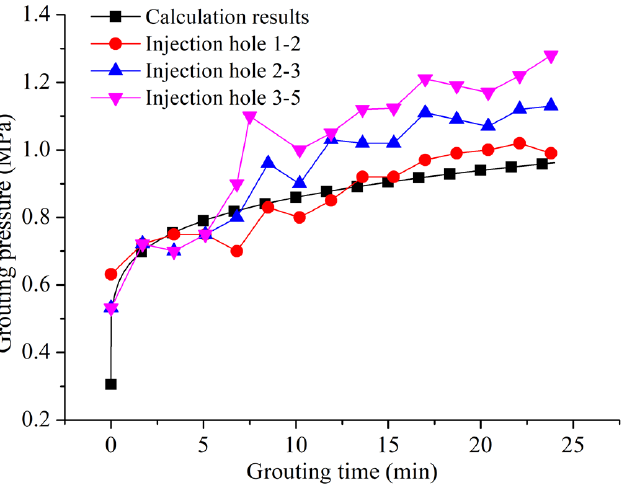
Figure 19. Comparison on grouting pressure (calculation results and monitored data).